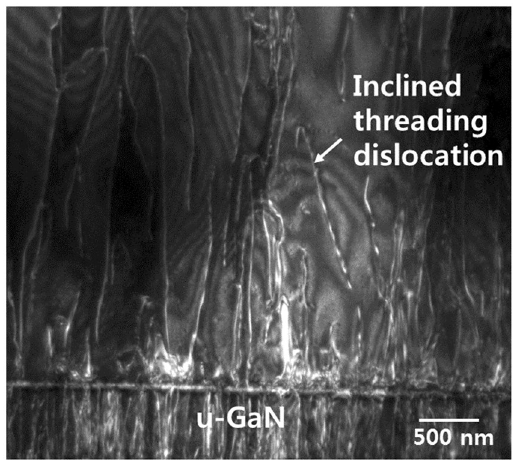
Figure 4. Dark field, cross sectional TEM image of the freestanding GaN crystals grown from Si substrates under diffraction vector g =